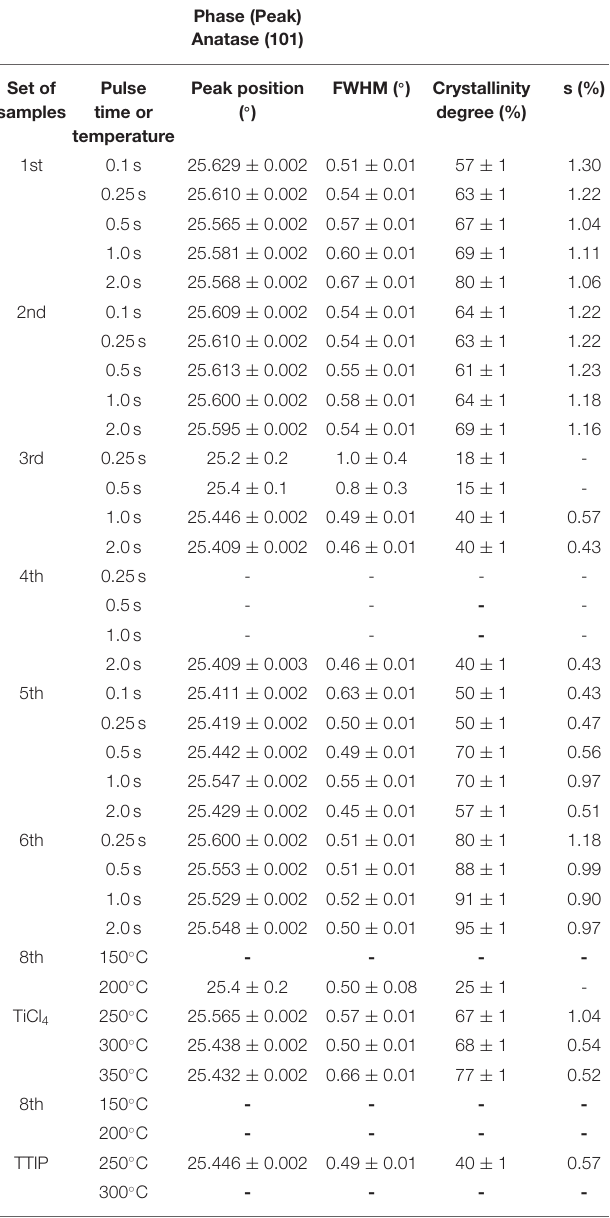
TABLE 3 | GIXRD peak (101) values and calculated strain from Figures 7 – 9 . Phase (Peak) Anatase